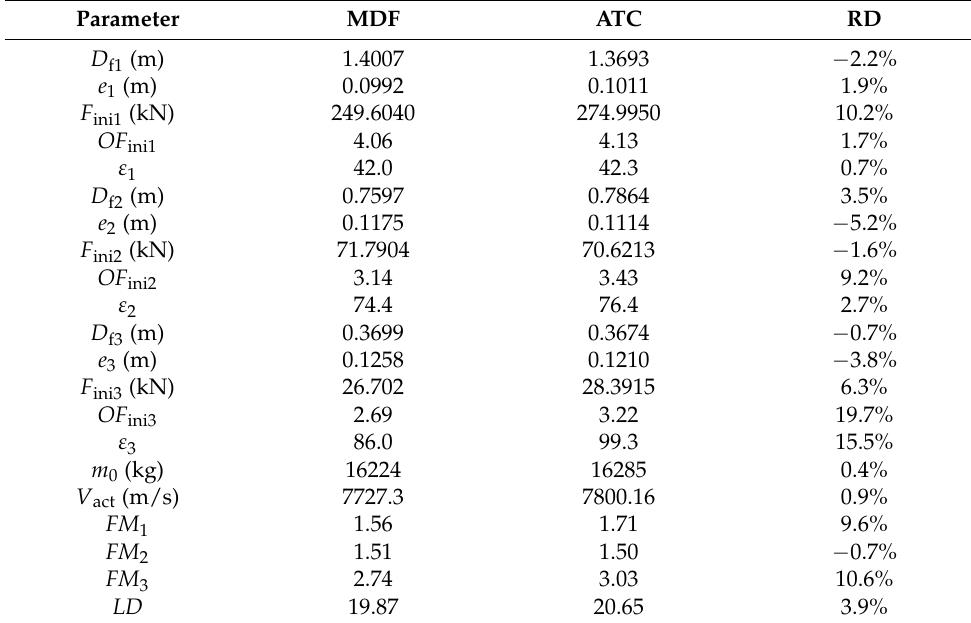
Table 5. Optimal results of LV design using the two different methods.